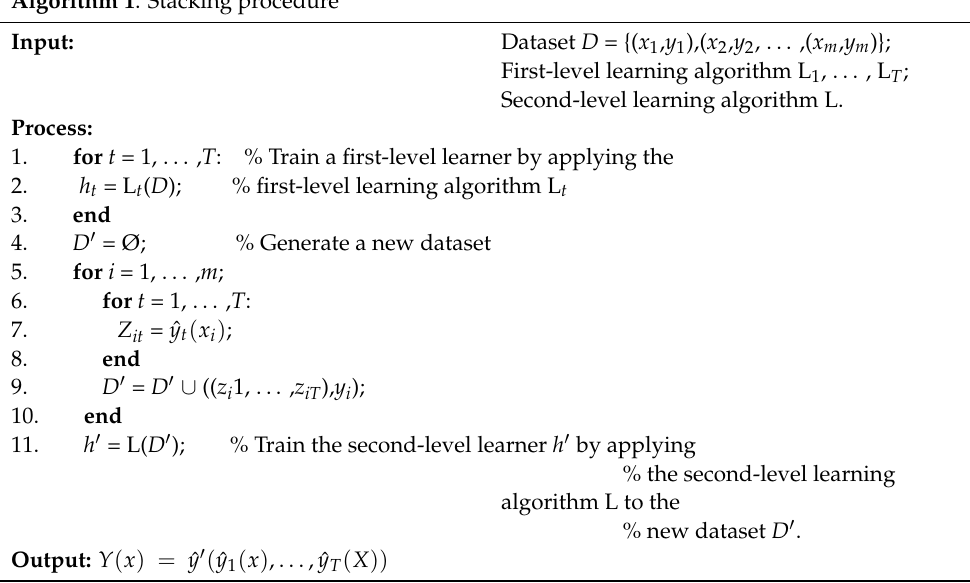
Figure 1. Stacking procedure.